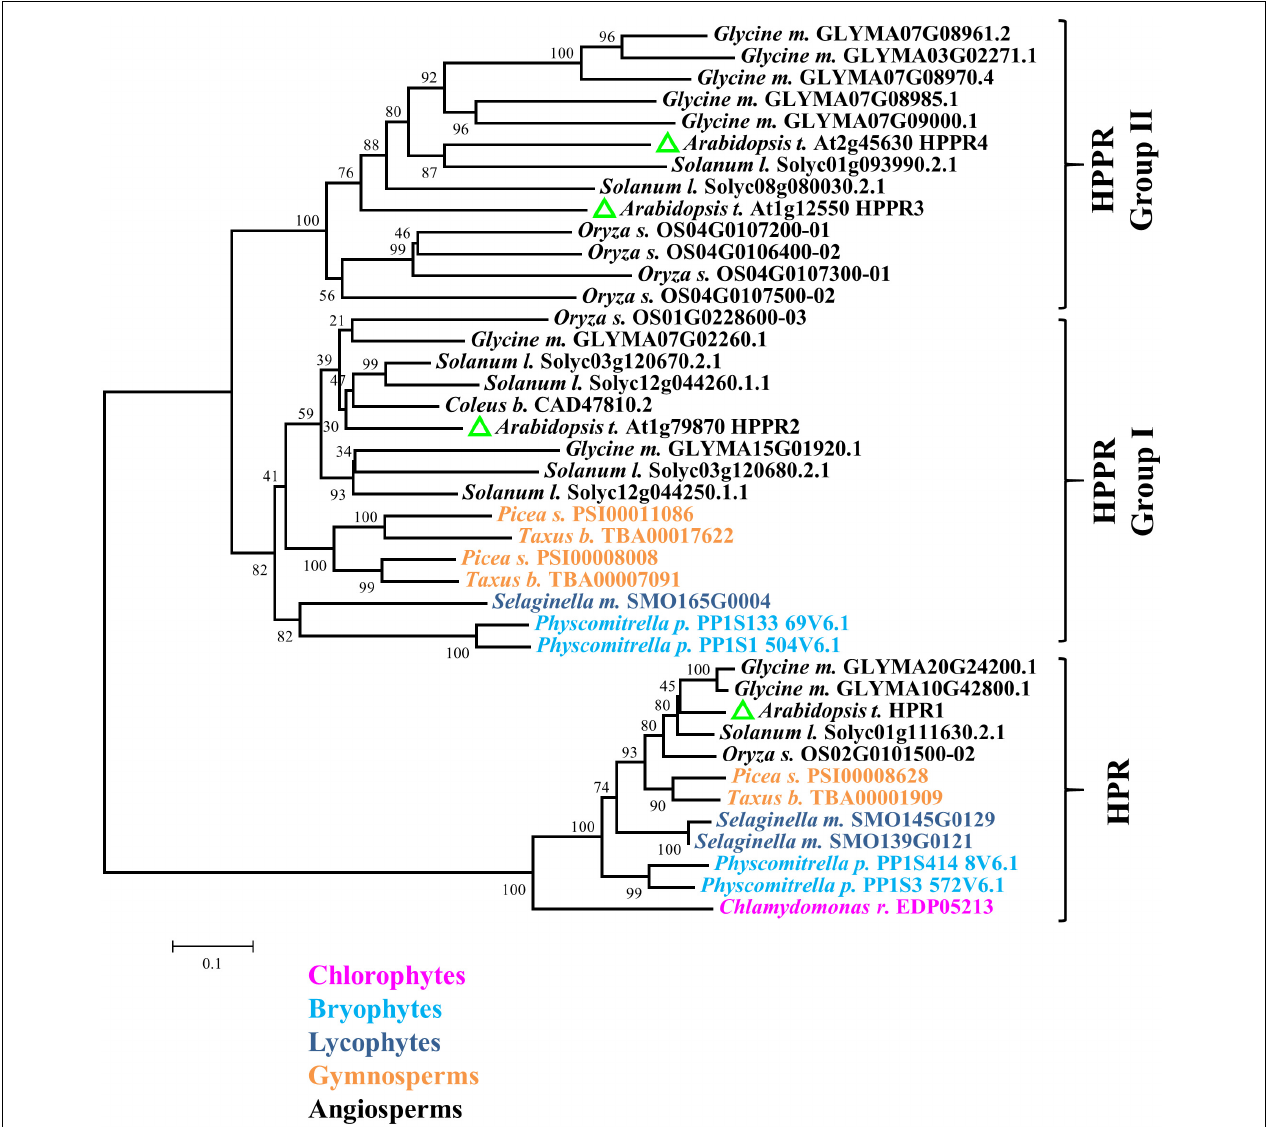
FIGURE 2 | HPPR homologs are widely distributed in land plants. The neighbor-joining method was used to perform a phylogenetic analysis of HPPRs and HPRs from Chlamydomonas reinhardtii , Physcomitrella paten s, Selaginella moellendorffii , Picea sitchensis , Taxus baccata , Oryza sativ a, Glycine max , Arabidopsis thaliana , Solanum lycopersicum , and Coleus blumei